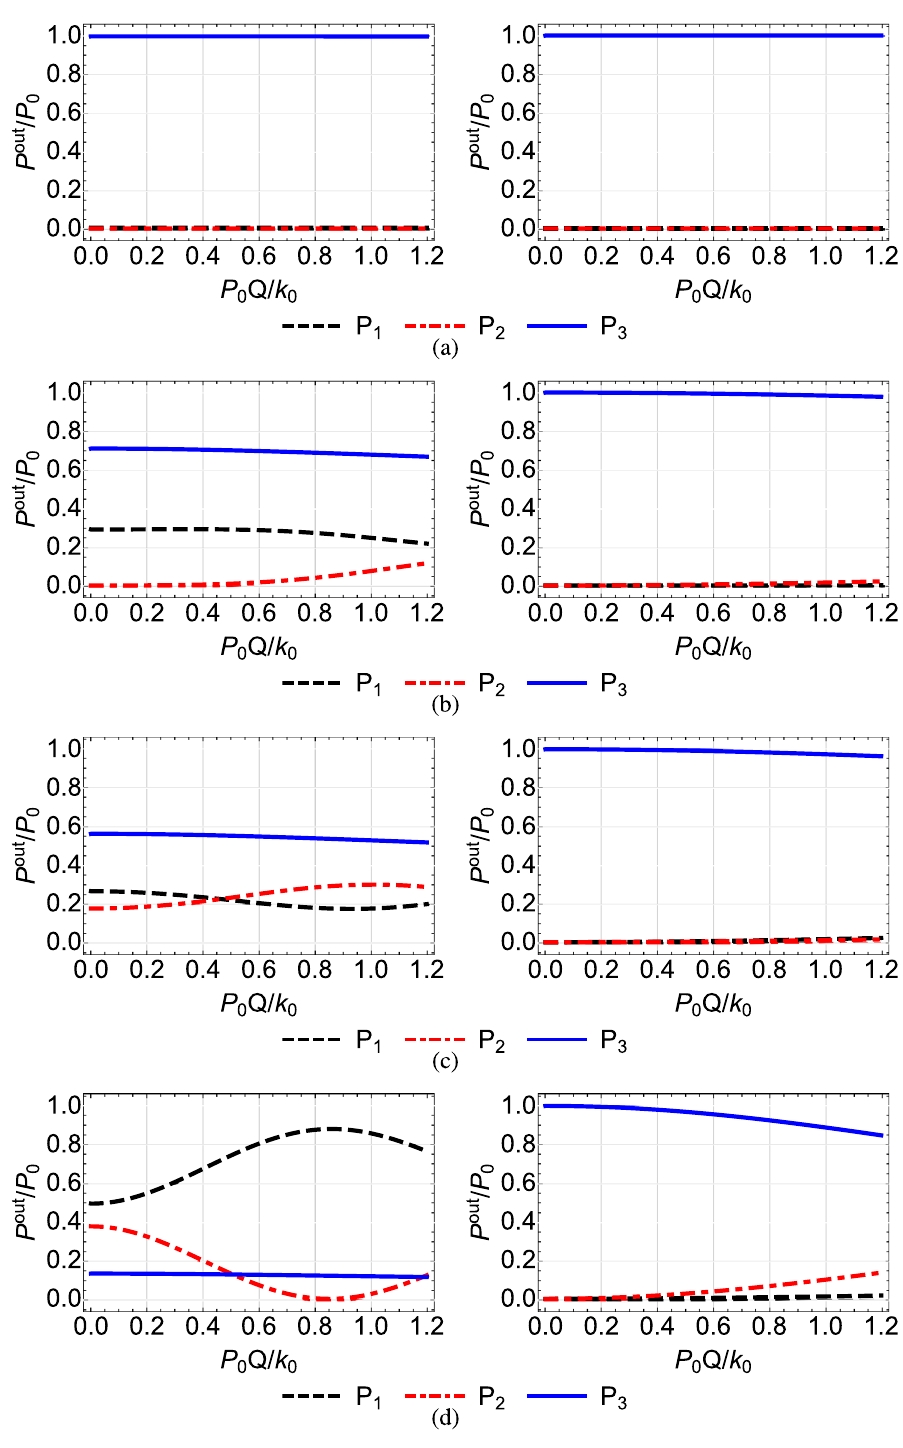
out P P i ( Z )/ P 0 0 at each waveguide as a function of the normalized i / = Q , Q 0, Q 2 0 , for the Gaussian (left column) and modified shortcut (right 3 = = =